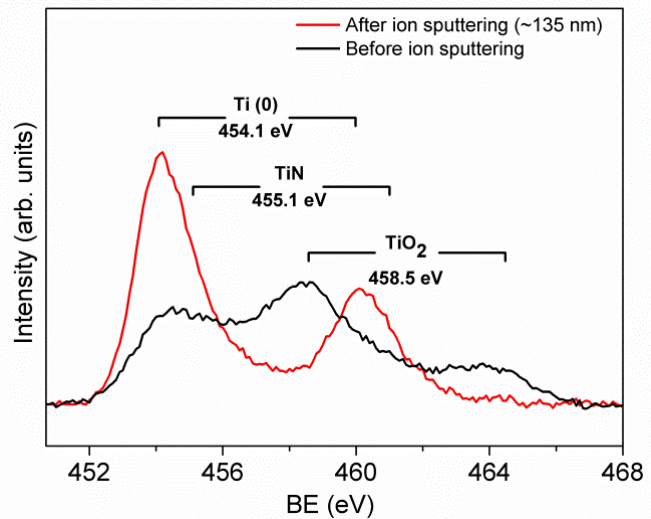
Figure 7. Comparison of the Ti2p signals acquired before and after Ar + ion sputtering [19]. Coatings 2020 , 10 , 1182